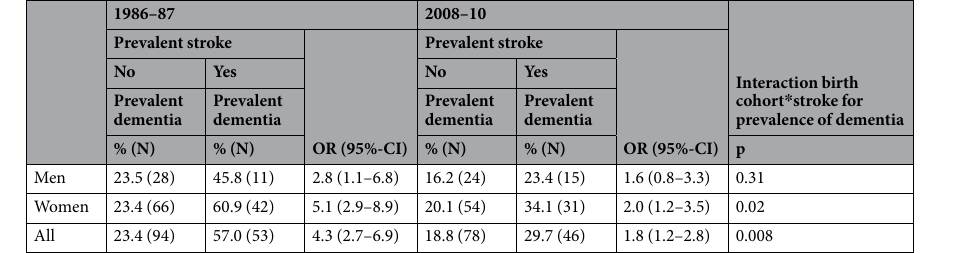
Table 4. Prevalence of dementia in relation to stroke in two birth cohorts of 85-year-olds. Odds ratio (OR) describes OR for dementia in prevalent stroke. No prevalent stroke is reference value for all odds